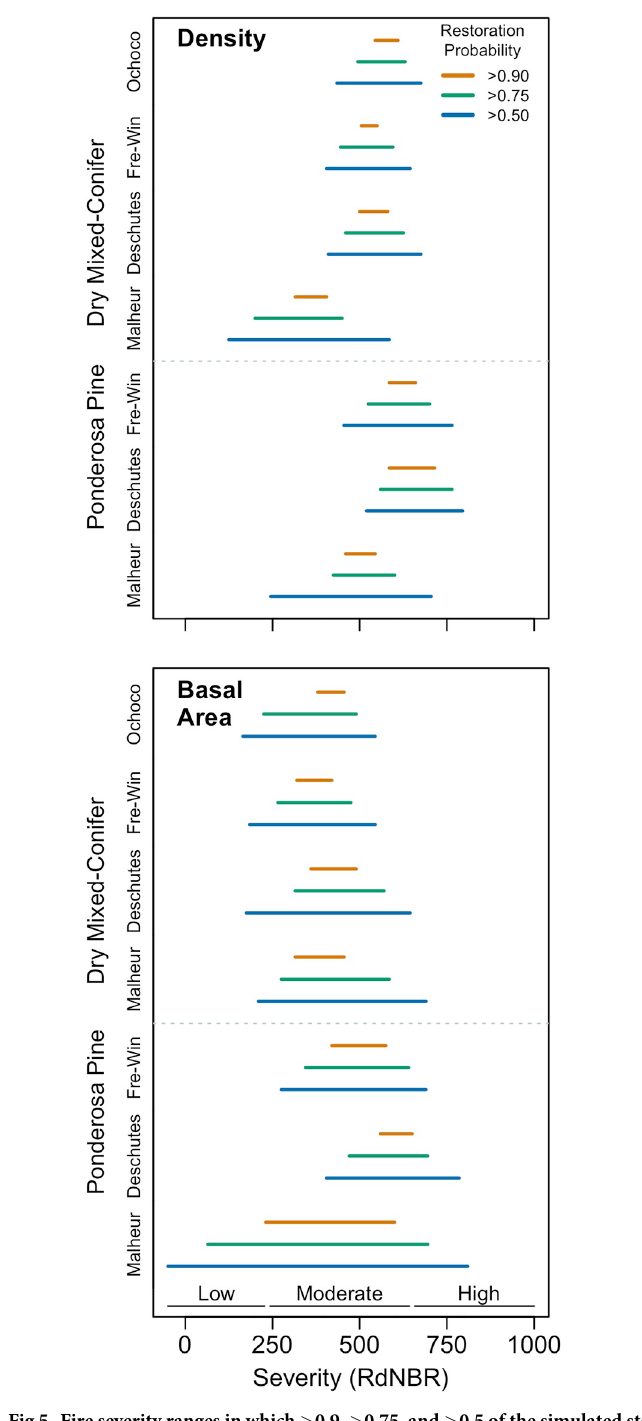
Fig 5. Fire severity ranges in which > 0.9, > 0.75, and > 0.5 of the simulated stands were within the basal area or diameter historical range of variation (mean ± 1SD) for all national forests and forest types assessed. Fire severity classes included for reference from